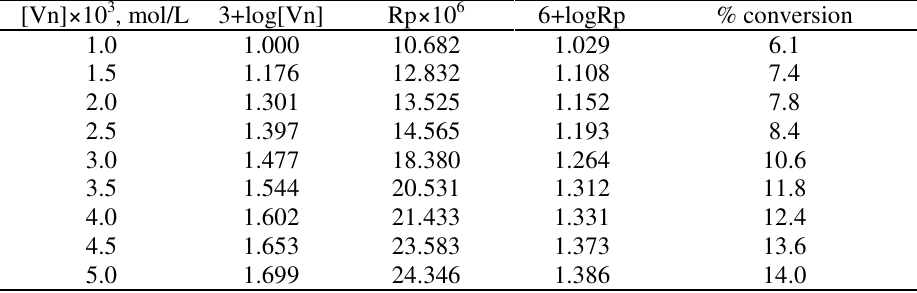
Table 2 . Dependence of rate on Ligand